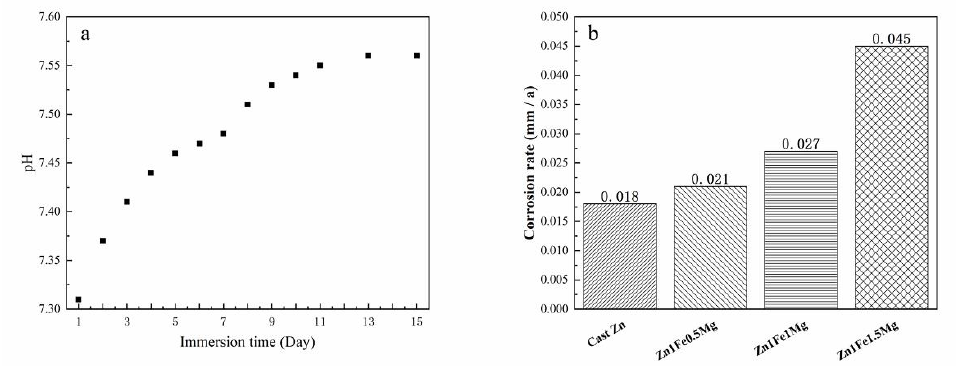
Figure 7. Change in the pH value of SBF solution with time after soaking the alloy (the ratio was 25 / 1 cm 2 ) ( a ) and Corrosion rates of alloys in SBF solution( b mL/1 cm 2 ) ( a ) and Corrosion rates of alloys in SBF solution( b ). 25 mL